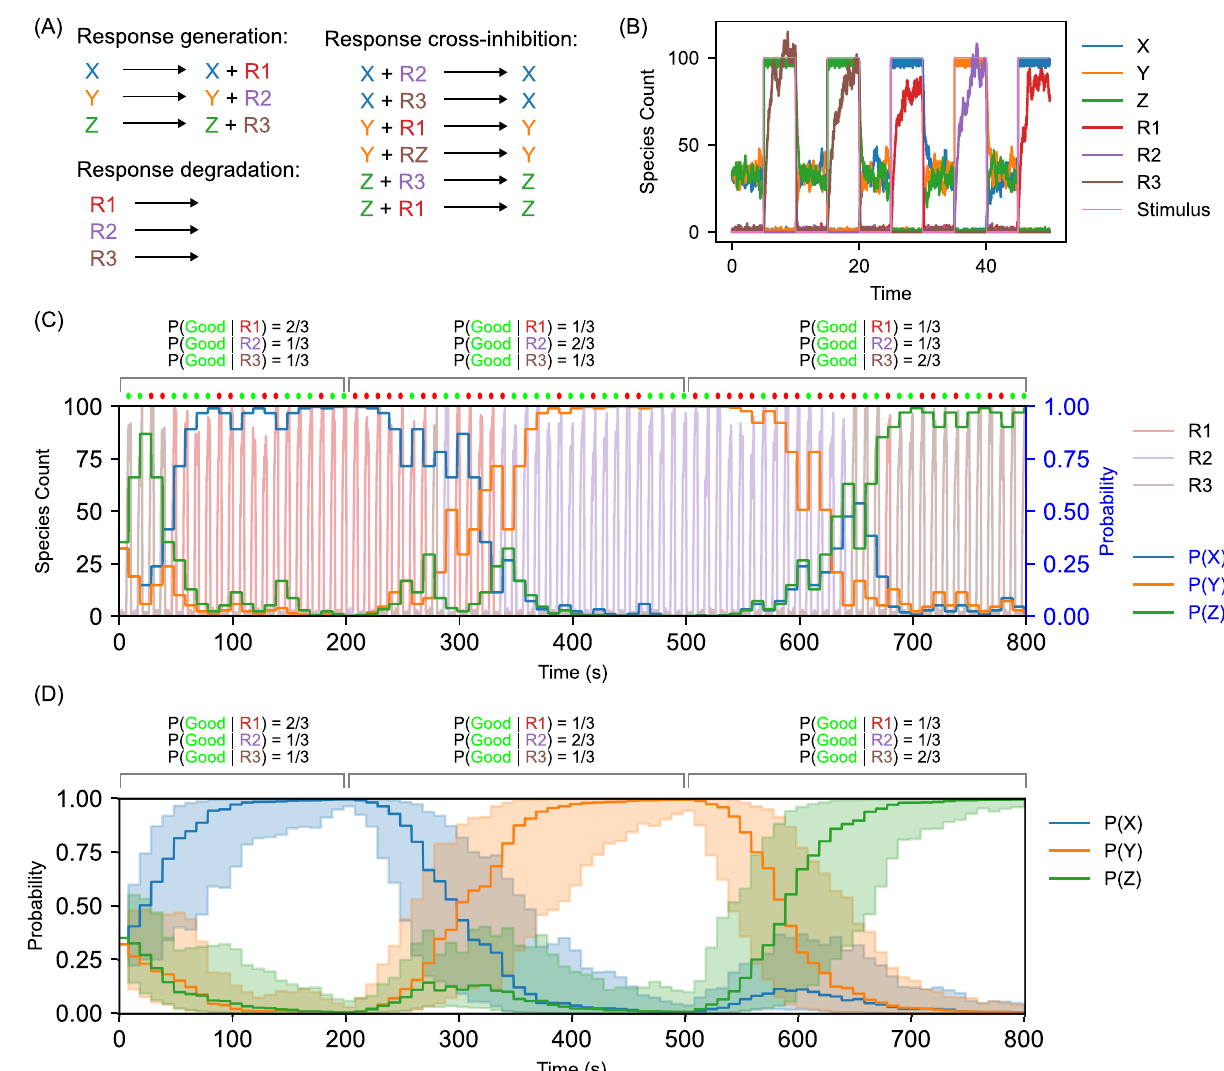
Fig 4. Generation of distinct response species from a ternary probabilistic decision-making CRN. (A) Additional reactions that can be added to the ternary decision-making CRN that link the decision species X , Y , and Z to the production of distinct “response” species R 1 , R 2 , and R 3 , respectively. Via the response generation reactions, each of the decision species catalyzes generation of the corresponding response species. Via the response cross- inhibition reactions, each of the decision species catalyzes degradation of the “other” response species. Finally, the response species also degrade via the response degradation reactions. The rate constants for the response generation reactions are kResponse = 1. The rate constants for the response cross- inhibition reactions are kResponseRepression = 1. The rate constants for the response degradation reactions are kResponseDecay = 1. (B) Representative time course illustrating the link from decision-making to the generation of distinct response species. When the decision-making species are at roughly equal counts during the entropy generation phases, the response species are generated but then immediately degrade each other, and thus the overall levels of the response species remain low. However, when a decision is taken in response to a stimulus and one decision species comes to dominate, it is able to promote generation of the corresponding response species while suppressing generation of the others. Thus, we can implement response generation that matches the decision but is expressed via a distinct abstract chemical species, which could represent an actuator. Initial species counts in this simulation were WX ¼ WY ¼ 33 and WZ ¼ 34 . (C) Representative time course from an operant conditioning simulation in a dynamic environment that administers probabilistic, time-dependent feedback based on observing the generation of response species by the CRN. Starting with decision species counts of X ¼ Y ¼ Z ¼ 33 and initial weight species counts of WX ¼ WY ¼ 33 and WZ ¼ 34 , 80 training cycles were run, with a stimulus of 100 molecules on for 4 time units and then off for 6 time units per cycle. The environmental feedback was a probabilistic, time-dependent response, similar to that from Fig 3 except that the feedback is now based on observed the response molecules, R 1 , R 2 , and R 3 , instead of the decision molecules directly. The threshold for determining which feedback to supply was set at 40 of one of the response molecules present; this is lower than the earlier simulations due to the greater stochasticity in the steady-state levels of the response species. When 0 < t < 200, the environment responds to R 1 with 10 Good molecules with probability 2/3 or with 10 Bad molecules with probability 1/3. In the same interval, the environment responds to R 2 or R 3 with 10 Good molecules with probability 1/3 and 10 Bad molecules with probability 2/3. These probabilities cycle to R 2 being favored when 200 < t < 500 and to R 3 being favored when t � 500. (We only report P ð Good j Rx Þ in the figure; P ð Bad j Rx Þ can be calculated straightforwardly as 1 (cid:0)